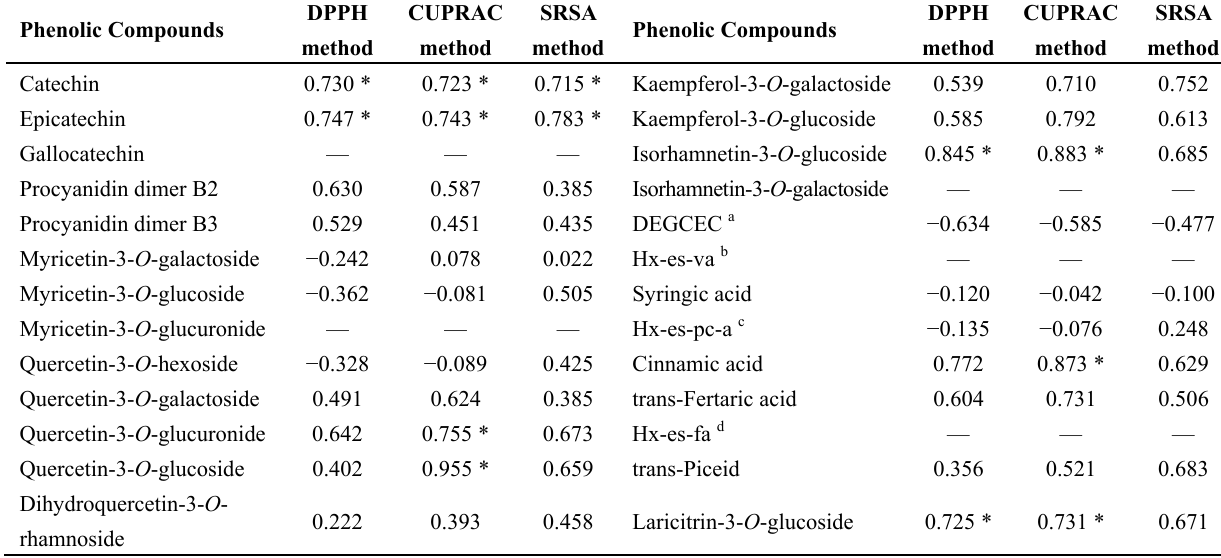
Table 4. Pearson’s correlation coefficients between antioxidant capacity (DPPH, CUPRAC and SRSA methods) and individual phenolic compounds in Cabernet Sauvignon and Merlot wines from four different wine grape-growing